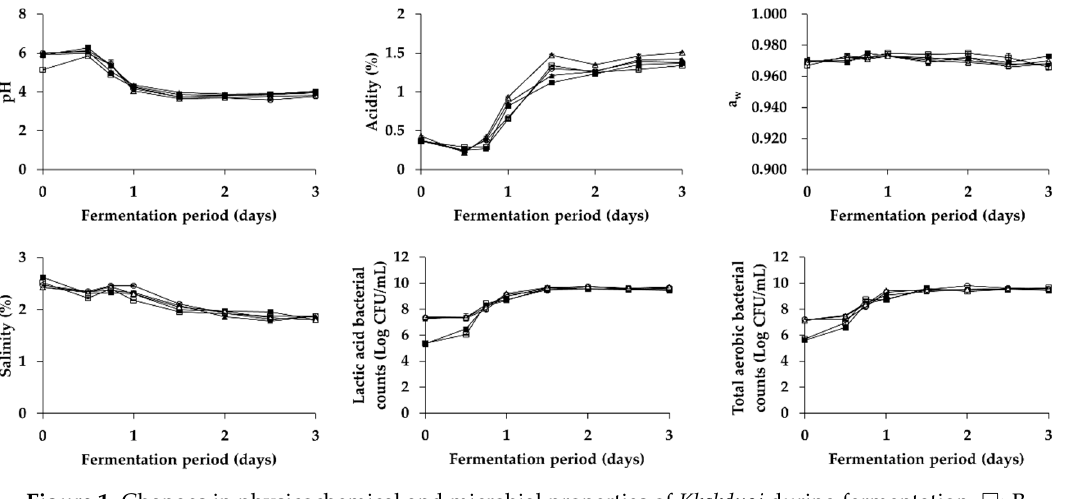
Figure 1. Changes in physicochemical and microbial properties of Kkakdugi during fermentation. □ : B (no addition of Myeolchi-aekjeot and Saeu-jeotgal , no inoculum), ■ : C (addition of Myeolchi-aekjeot and Saeu-jeotgal , no inoculum), ▲ : PC (addition of Myeolchi-aekjeot and Saeu-jeotgal , L. brevis JCM 1170), : LB (addition of Myeolchi-aekjeot and Saeu-jeotgal , L. brevis KD3M5), : LP (addition of Myeolchi-aekjeot and Saeu-jeotgal , L. plantarum KD3M15).